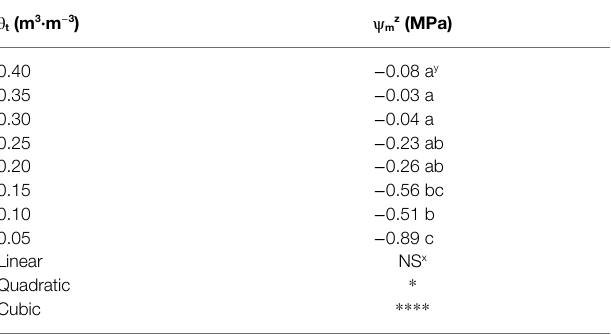
TABLE 1 | Substrate matric potential ( ψ m ) at eight substrate volumetric water content treatments ( θ t ) recorded on 11 January